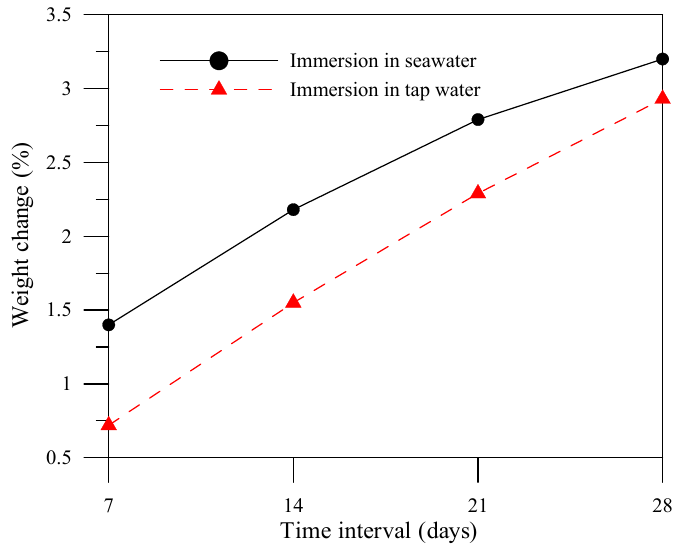
Figure 6. Trend of weight change between seawater and tap water (black line: seawater).